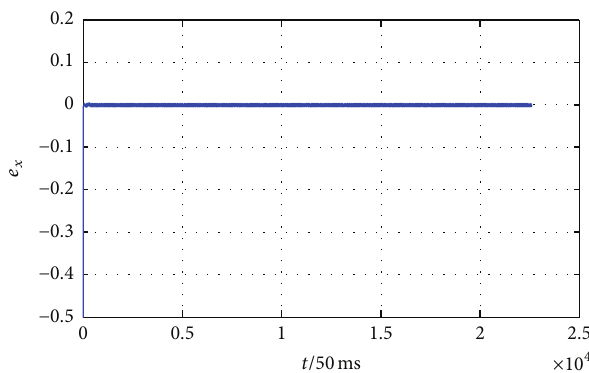
Figure 10: The curve 𝑒 𝑦 for multivariable feedback system.